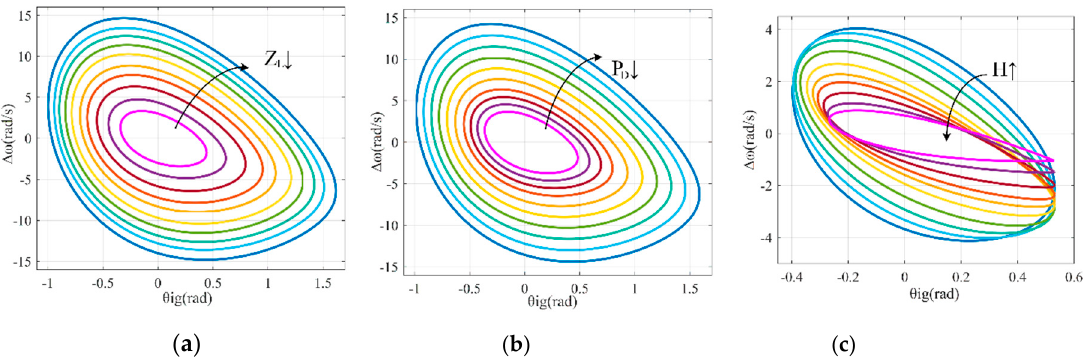
Figure 10. The stability domain. ( a ) Under different impedance of cable; ( b ) Under different load power; ( c ) Under different virtual inertia.